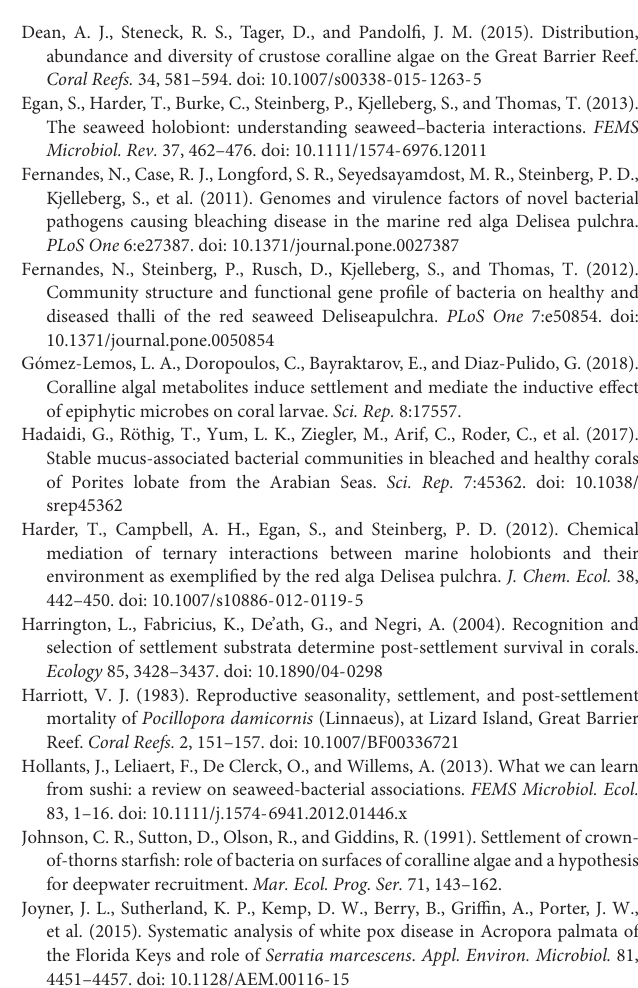
Supplementary Figure 1 | Coral larvae exposed to (A) healthy, (B) middle, and (C) bleached P. onkodes . Red arrows represent different health statuses of P. onkodes , while green arrows indicate coral larvae. Supplementary Figure 2 | Venn diagram showing the number of OTUs in healthy, middle, and bleached P. onkodes based on the 16S RNA gene database at the cut-off level of 97%. Supplementary Figure 3 | The beta diversity of bacterial communities associated with P. onkodes based on a hierarchical cluster tree and principal coordinates analysis (PCoA). The values of axes 1 and 2 represent the percentages that can be explained by the corresponding axis. Supplementary Table 1 | Analysis of variance on larval settlement/metamorphosis/swimming rates exposed to different health statuses of P. onkodes